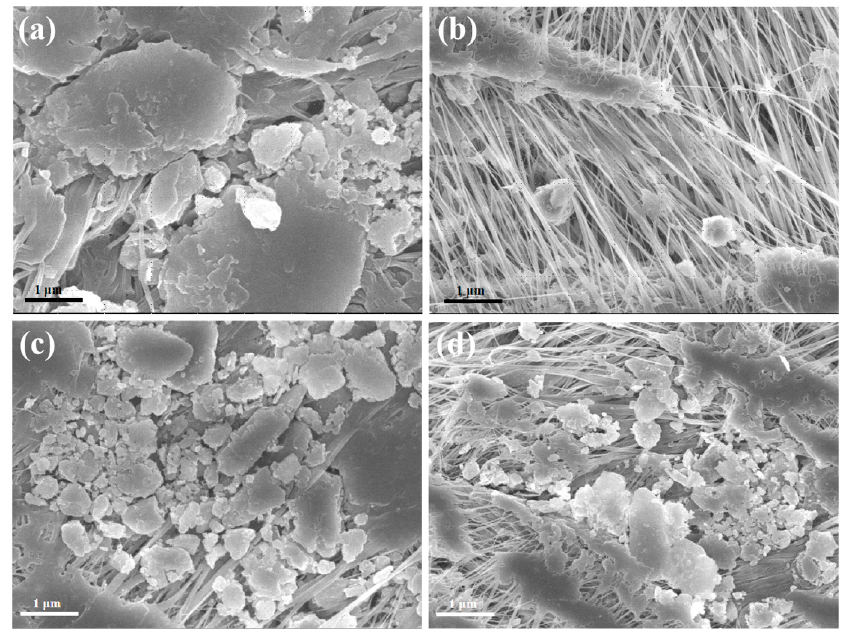
Figure 2. SEM images of PM particles from ( a ) bare land, ( b ) stock dump, ( c ) construction, and ( d ) road dust captured on